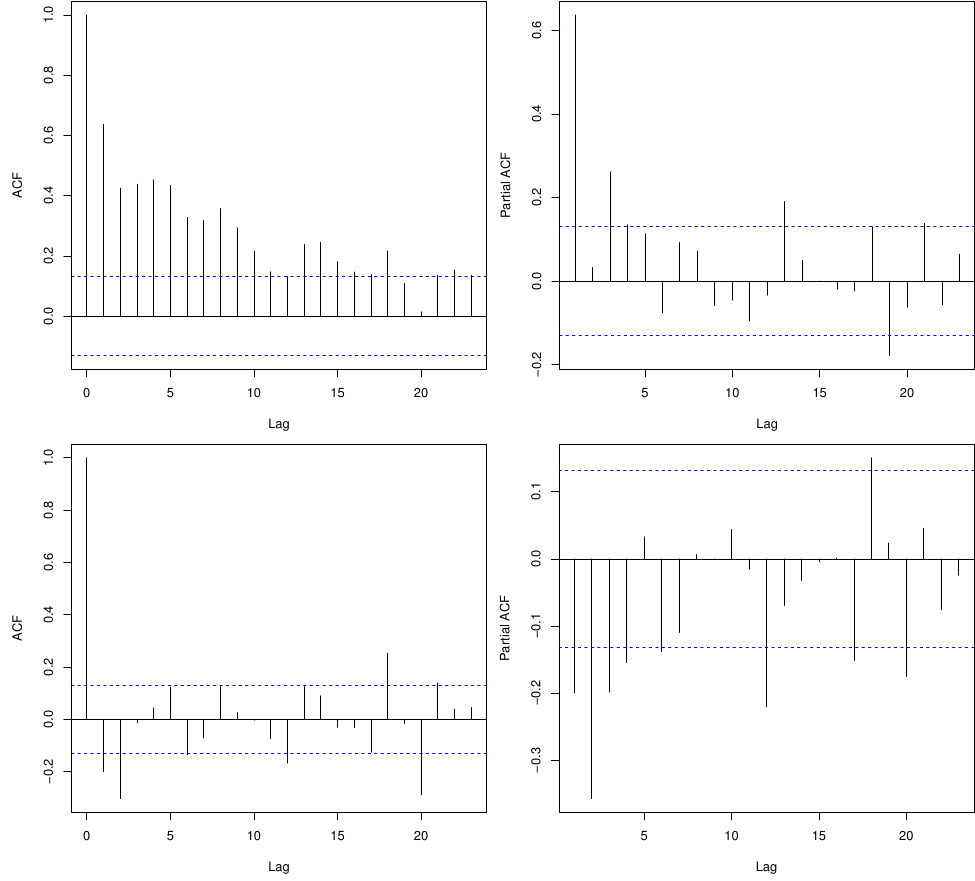
Figure 15. ACF and PACF for level ( first row ) and differenced data ( second row